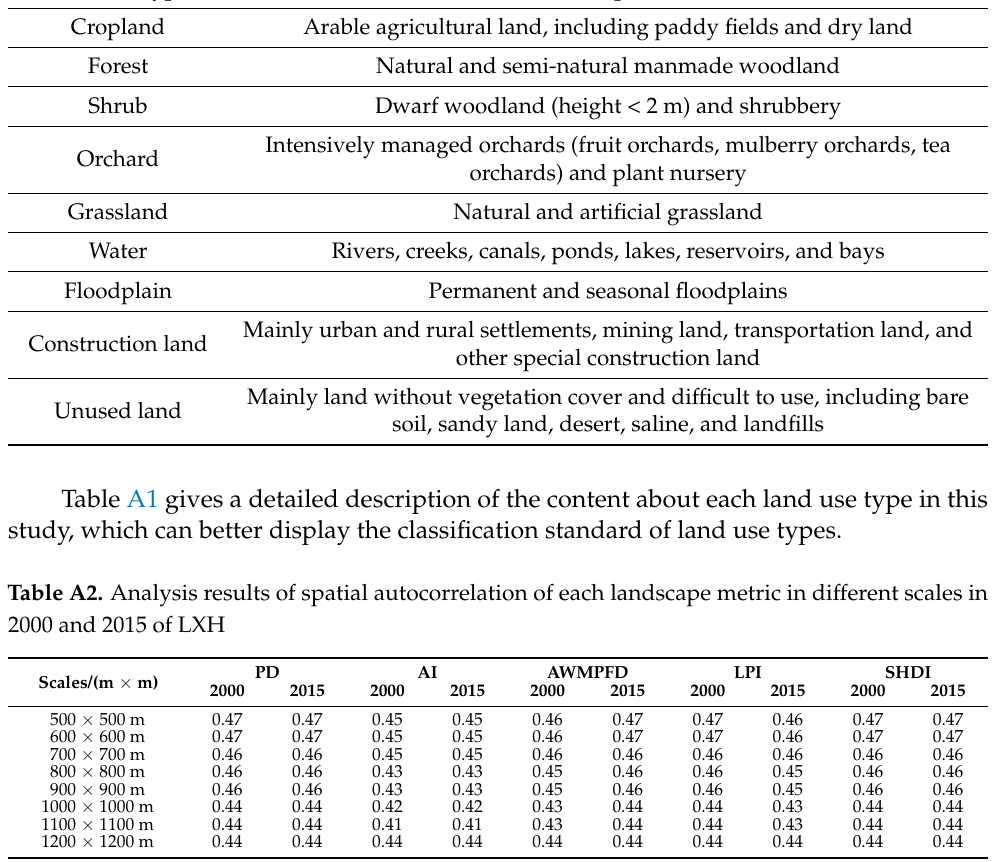
Table A1. Description of land use types in the LXH. Land Use Types